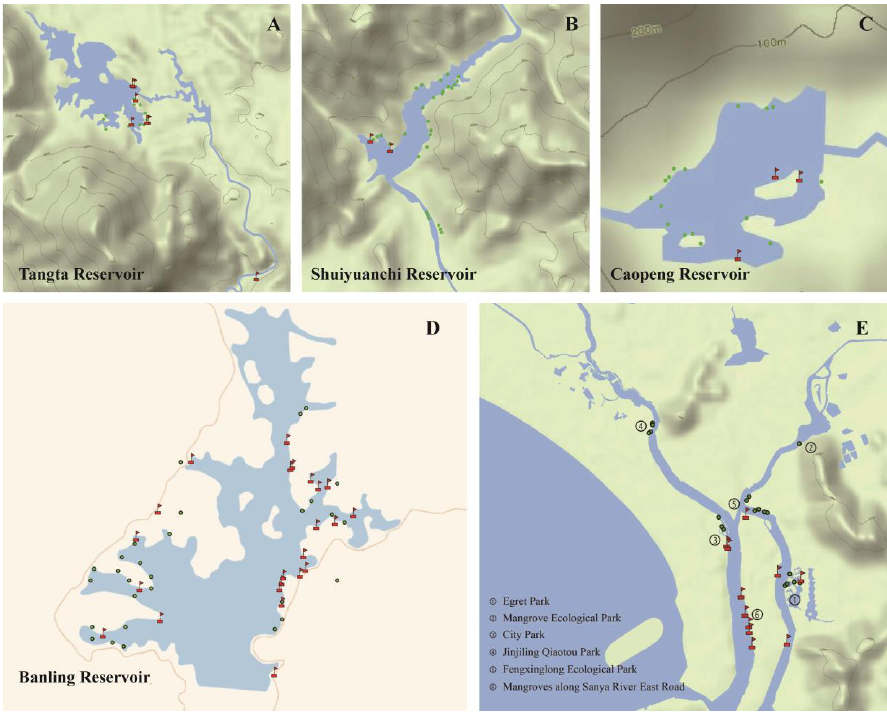
Figure 2. Distribution of samples in the Sanya River Basin, Hainan Province, China; represent- ing the quadrat containing rare and endangered plants; representing the quadrat without rare and endangered plants. A : Sample plot distribution map of Tangta Reservoir; B : Sample plot distri- bution map of Shuiyuanchi Reservoir; C : Sample plot distribution map of Caopeng Reservoir; D : Sample plot distribution map of Banling Reservoir with the second richest species and the largest species number of rare and endangered plants; E: Distribution map of sample plots of five parks in the city center, mainly mangroves. Table 2. Vegetation types and their coverage area in Sanya River Basin, Hainan Province, China. It can be divided into natural vegetation and artificial vegetation. The area of the reservoir is much larger than that of mangroves, and more plants can survive. Vegetation Type